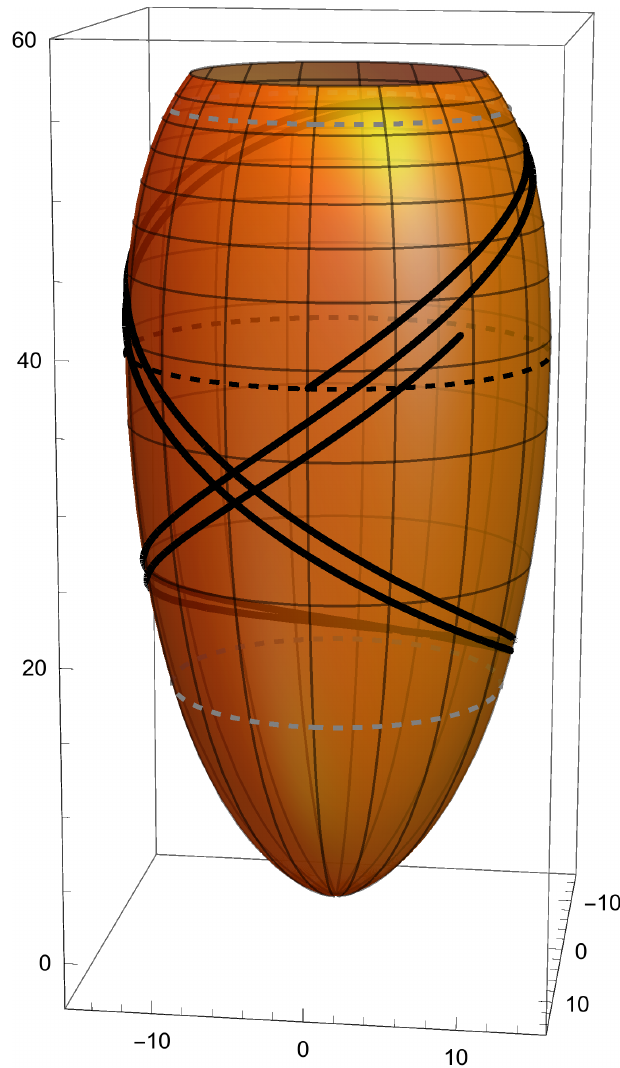
Figure 11. Prograde geodesic with turning points at r t = 11.5. This geodesic starts as northbound at the equator, marked by a black-dashed latitude. Two more crossings of the equator are shown, each advancing by a positive shift of ∆ φ = 0.2088. A = 525.6 and B =